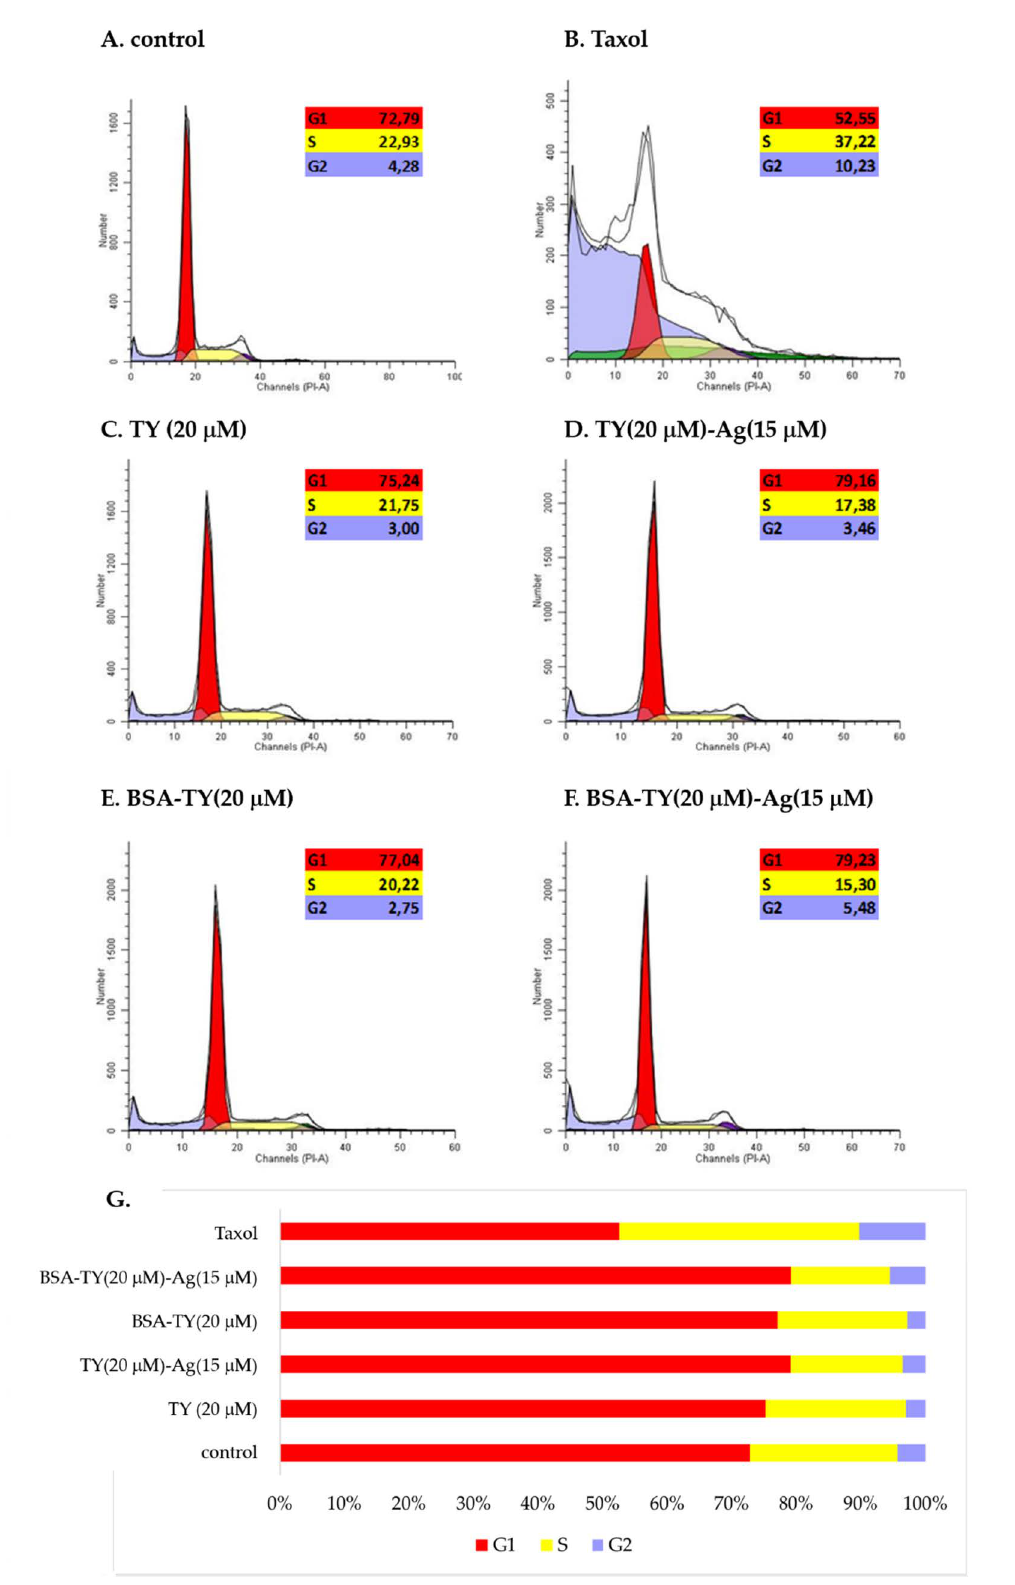
Figure 16. The effect of ( B ): taxol, ( C ): TY, ( D ): TY-Ag, ( E ): BSA-TY, and ( F ): BSA-TY-Ag on the cell cycle of T24 cells. ( A ): control; ( G ): percent of cells at G1, S or G2 phase of cell cycle.